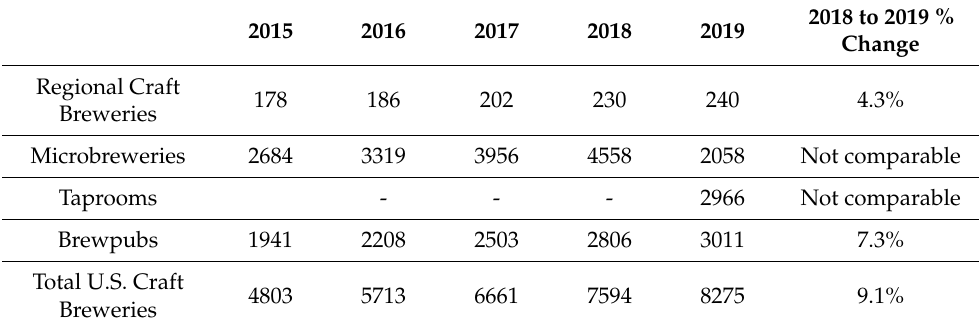
Table 1. Development in the number of microbreweries in the US